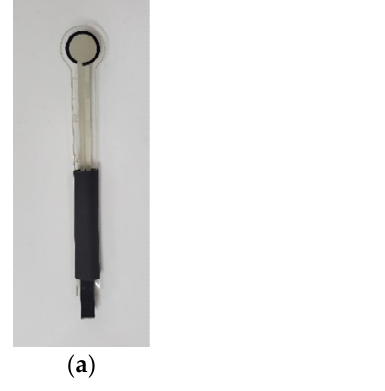
Figure 6. The force sensor device: ( a ) the flexible force sensor foil, and ( b ) the schematic diagram of the flexible force sensor foil connecting to a data acquisition toolbox. The data acquisition toolbox transmits data to the personal computer next to the machine tool through Bluetooth. Table 4. The specification of the force sensor device.